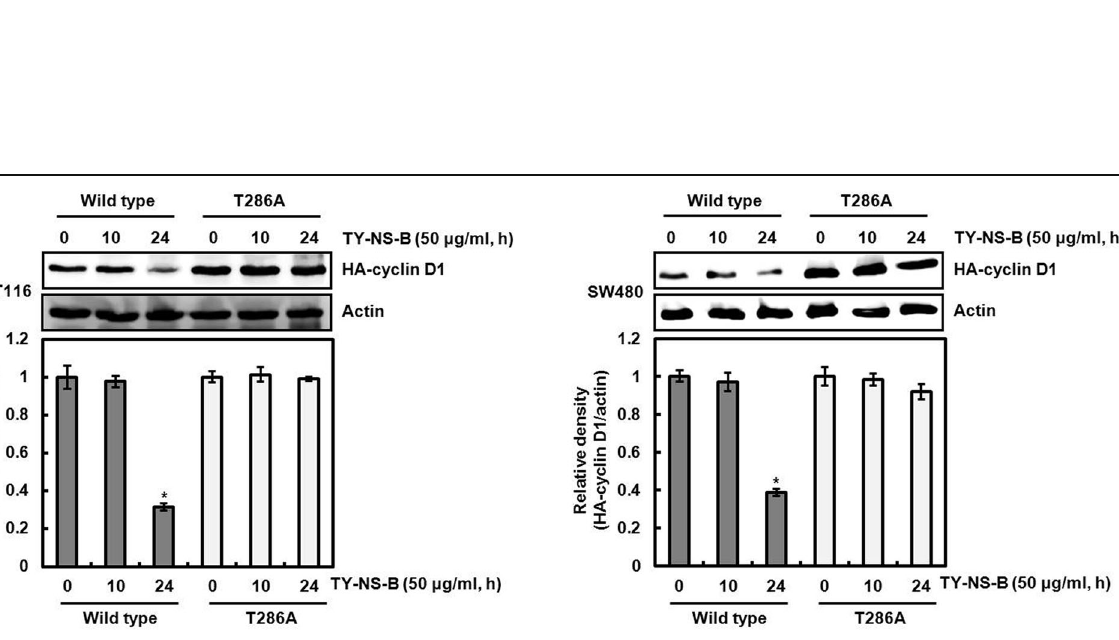
Fig. 6 Cyclin D1 degradation by TY-NS-B is dependent on T286 phosphorylation. HCT116 and SW480 cells were transfected with HA-tagged wild type-cyclin D1 or T286A-cyclin D1, and then co-treated with TY-NS-B (50 μ g/ml) for the indicated times. Cell lysates were subjected to SDS-PAGE and the Western blot was performed using antibody against HA-cyclin D1. Actin was used as internal control for Western blot analysis. Relative density for Western blot was measured using the software Un-SCAN-IT gel Version 5.1 (Silk Scientific, Inc). Data represent mean ± SD for three independent experiments. * P < 0.05 compared to cell without